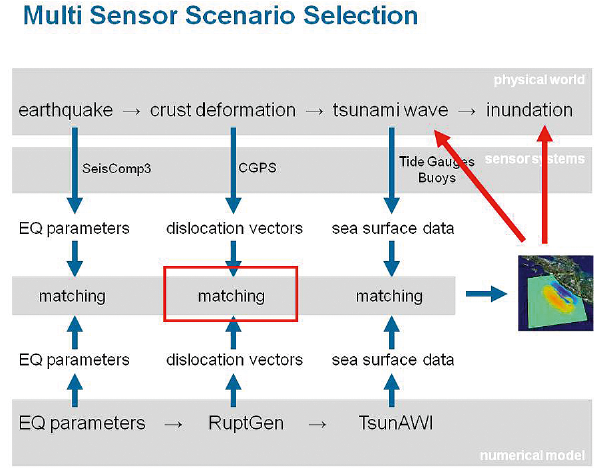
Fig. 3. The sketch shows the matching procedure for the simulation system taking the different sensor data in consideration (Behrens, personal communication,